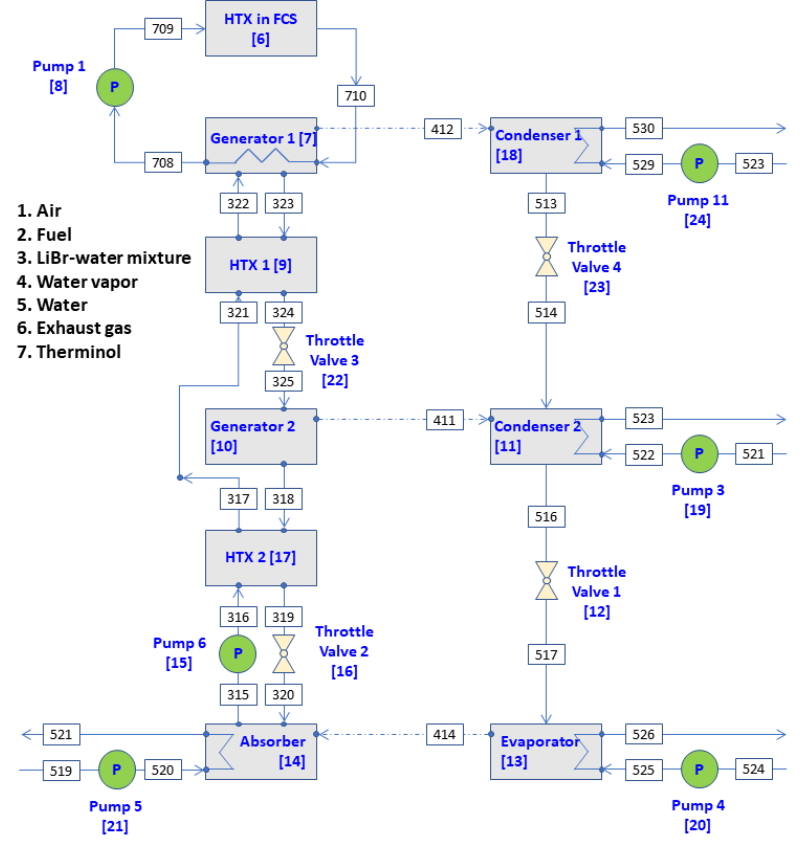
Figure 3. Schematic of series double effect LiBr–water absorption refrigeration system.